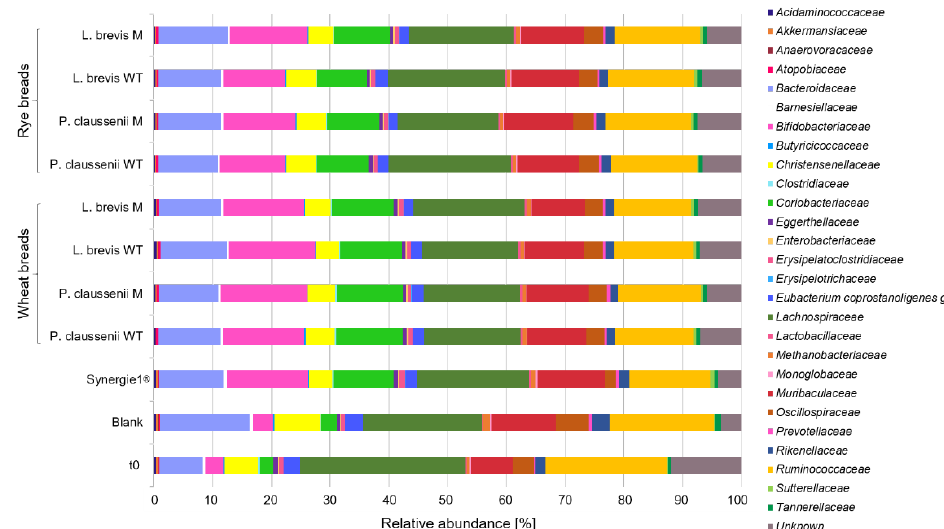
Figure 2. Relative abundance [%] of bacterial families in fermentation pellets (FP) of controls (blank, Synergy1 ® ) and in FP of wheat and rye breads obtained after sourdough fermentation with wild-type (WT) and mutant (M) strains of Pediococcus claussenii (WT: TMW 2.340, M: TMW 2.2123) and Levilactobacillus brevis (WT: TMW 1.2112, M: TMW 1.2320). TMW: Technische Mikrobiologie Weihenstephan.